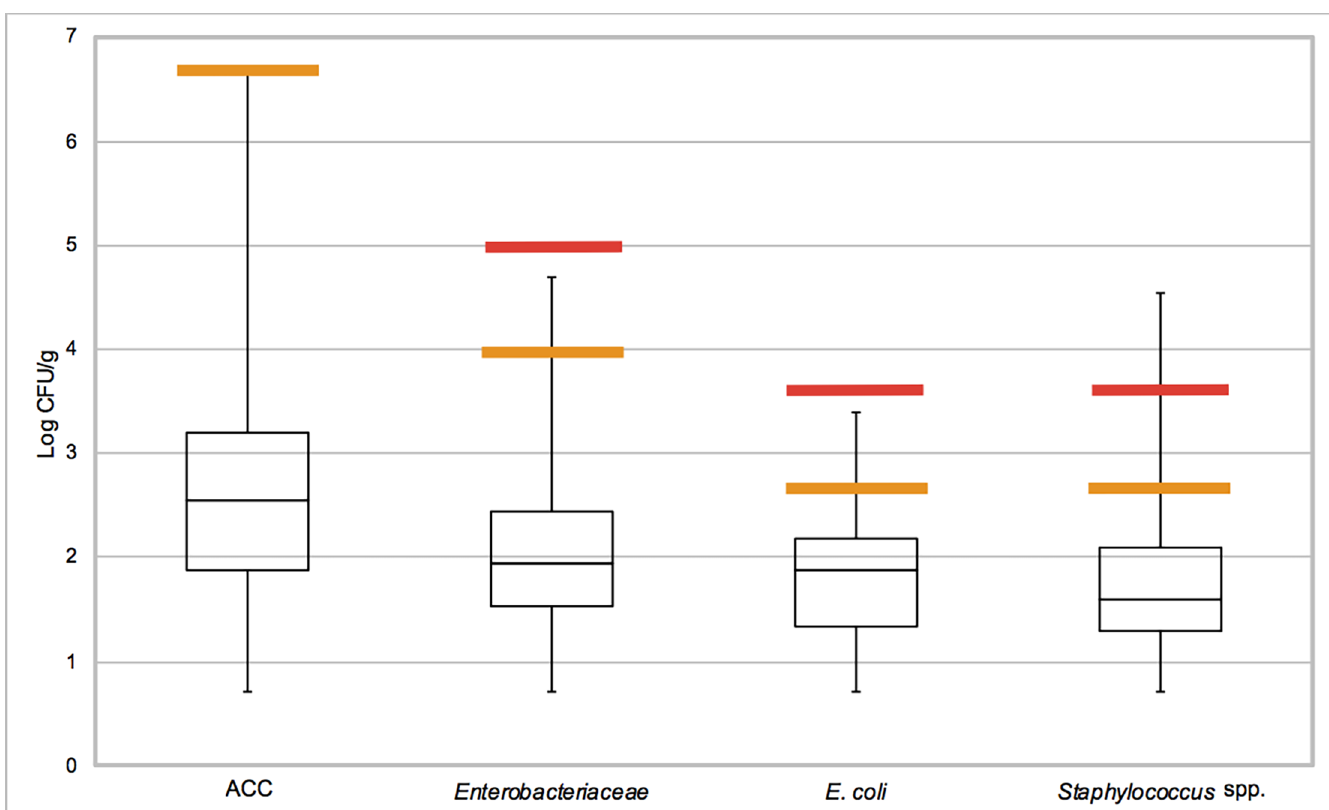
Fig 2. Boxplot of the mean concentration of four microbiological criteria (Aerobic colony count (ACC), Enterobacteriaceae , E . coli , and staphylococci) in 498 poultry meat consignments cleared by the BIP Hamburg harbour in the years 2014 and 2015. Yellow bold bars indicate the target value, red bold bars indicate the critical value to classify the quality